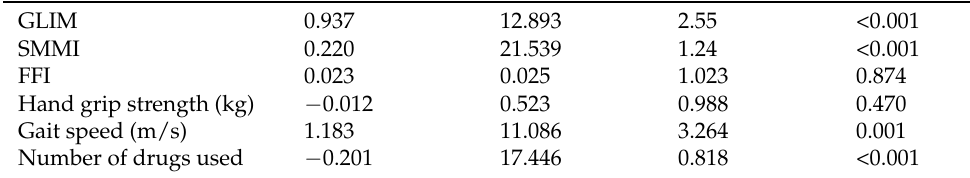
Table 5. Results of logistic regression analysis.